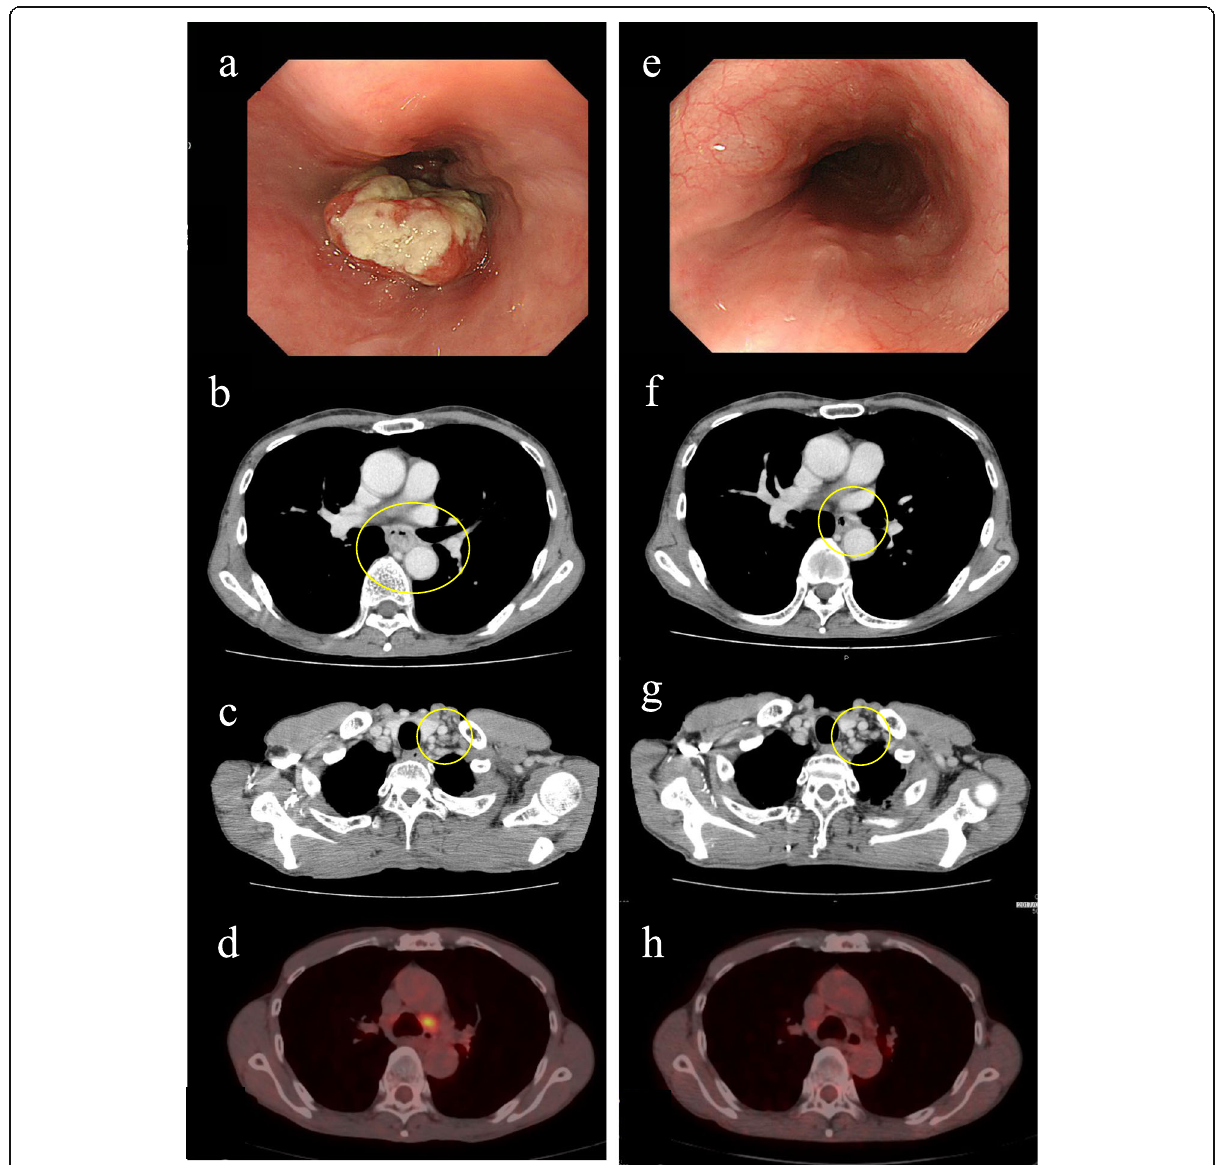
Fig. 1 Endoscopy and imaging before neoadjuvant chemotherapy (NAC) for esophageal cancer ( a – d ) and the findings after NAC ( e – h ). Endoscopy revealed marked shrinkage of the primary tumor ( a , e ). Computed tomography also revealed contraction of the primary tumor (indicated by a yellow circle in b , f ). The sizes of the cervical lymph nodes defined as no. 104 by the Japanese Esophageal Society were stable after NAC (indicated by a yellow circle in c , g ). Positron emission tomography also decreased uptake in the primary tumor ( d , h